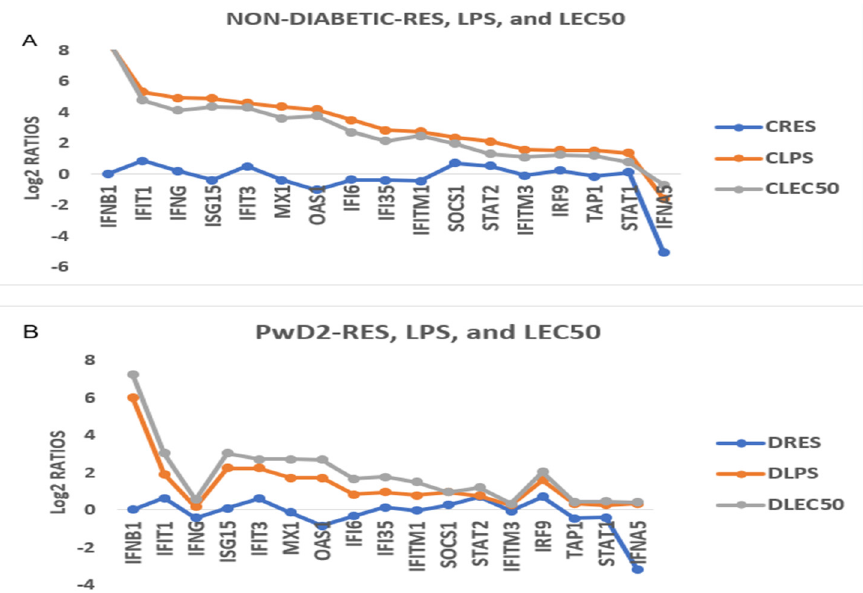
Figure 5. IFN-induced genes were downregulated in PBMCs from PwD2 as compared to non-diabetic controls in response to LPS, except for IFN- β . RES showed an inhibition or no change in gene expression, whereas LPS and LEC10 showed an upregulation of these genes. CRES, CLPS, and CLEC50 (controls) and DRES, DLPS, and DLEC50 (PwD2) were compared. ( A ) Non-diabetic control and ( B ) PwD2.